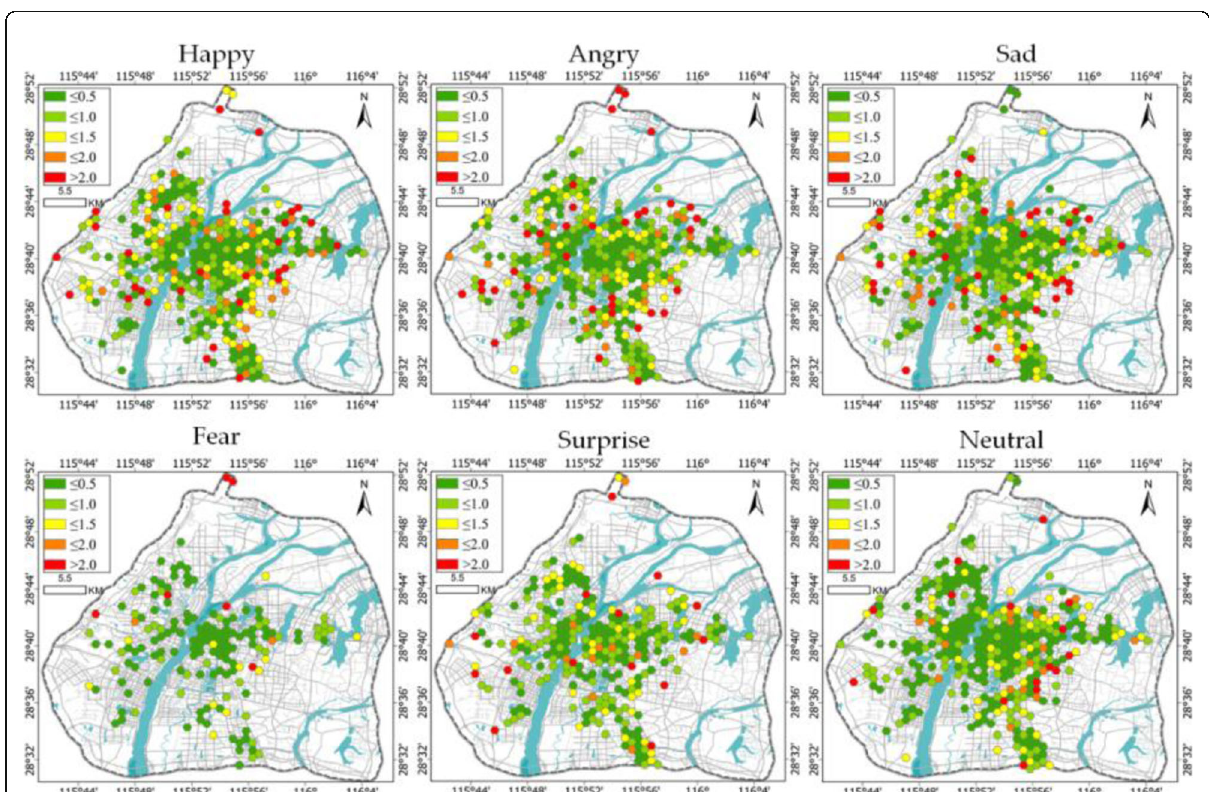
Fig. 10 The spatial pattern of the LISA of the emotions from weekday to